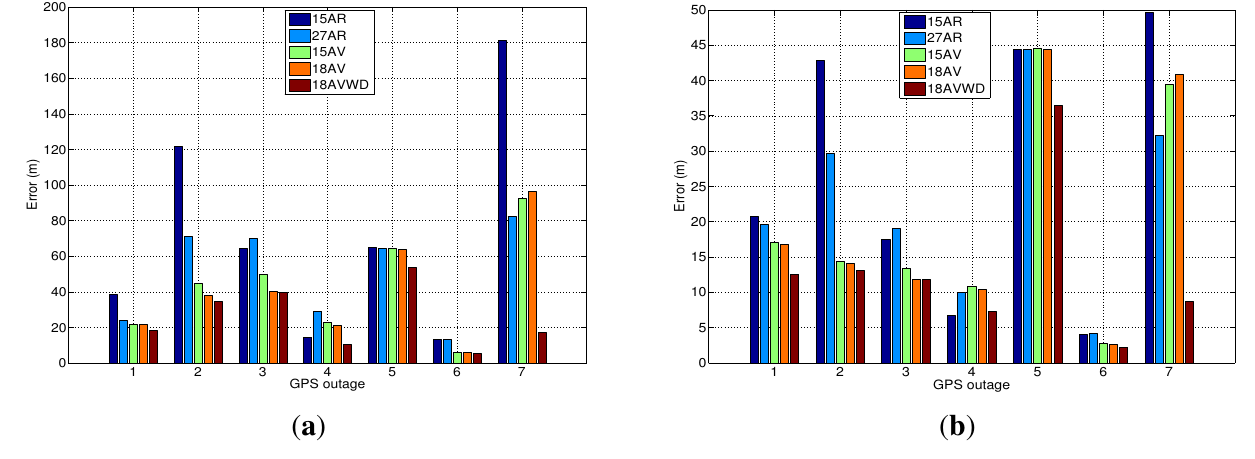
Figure 26. ( a ) Maximum horizontal position error for whole the GPS outage introduced in both trajectories; ( b ) mean horizontal position error for whole the GPS outage introduced in both